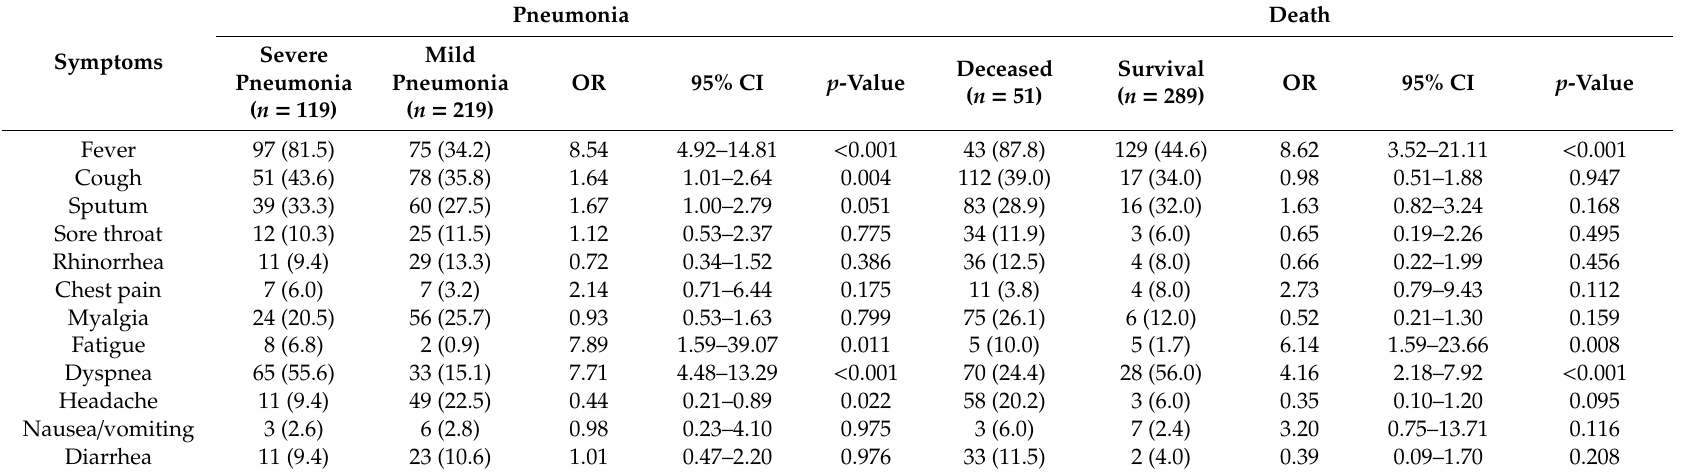
Table 2. Binary logistic regression analysis predicting odds of symptoms in patients with